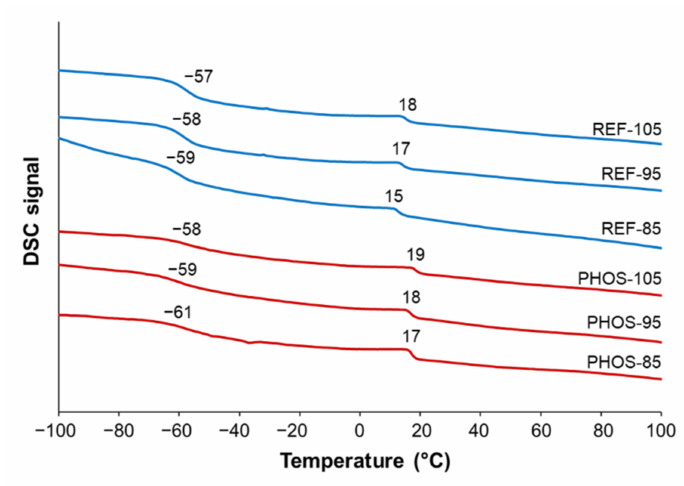
Figure 5. DSC curves of flexible foams (inert atmosphere).